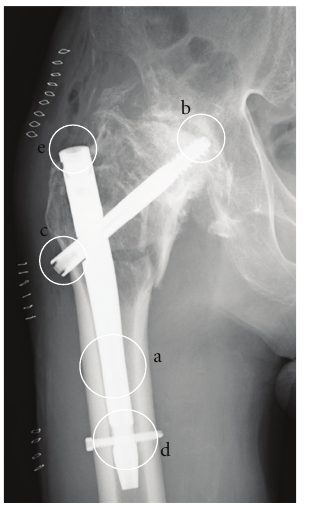
Figure 5: Anteroposterior radiograph after the operation showing the important points of operation for an intertrochanteric fracture of an ankylosed hip, represented with five circles